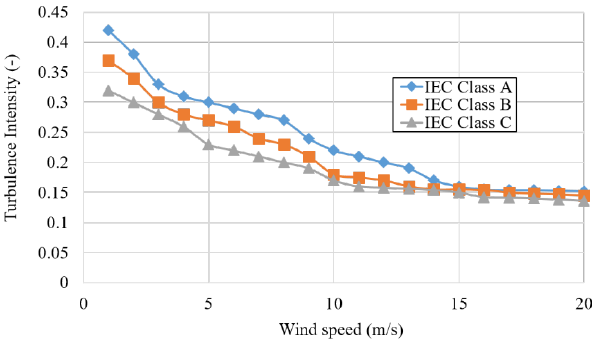
Figure 8. Wind turbine sub-classes categorized by IEC .